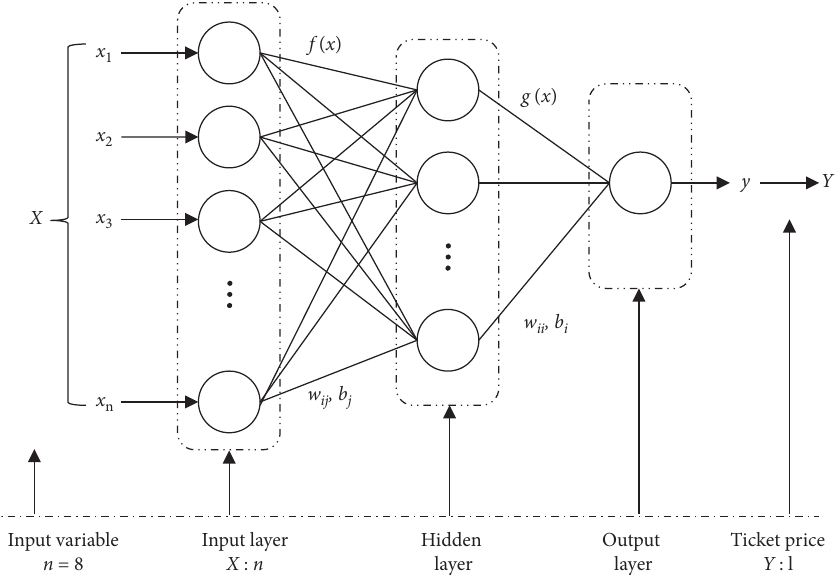
Figure 1: Structure diagram of the neural